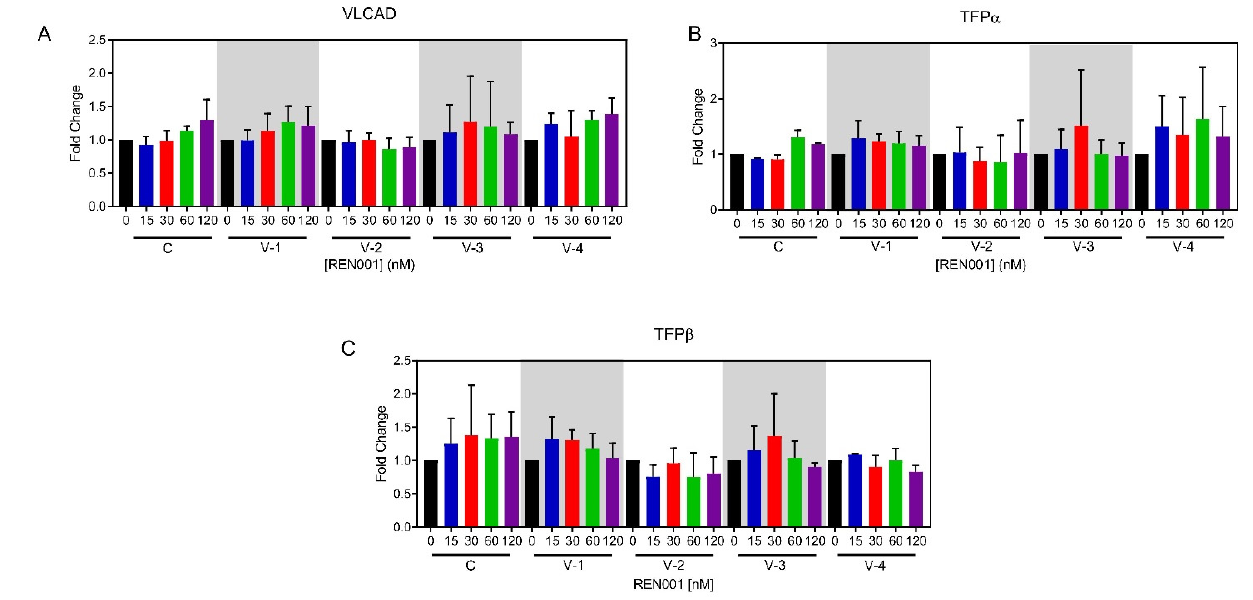
Figure 2. VLCAD ( A ), TFP α ( B ), and TFP β ( C ) cellular protein content was quantified from Western blots of whole cell lysates prepared from REN001-treated fibroblasts. Data are presented as fold changes compared to values at 0 nM treatment (n = 3 for all assays). t -tests were performed and no statistical significance was observed.